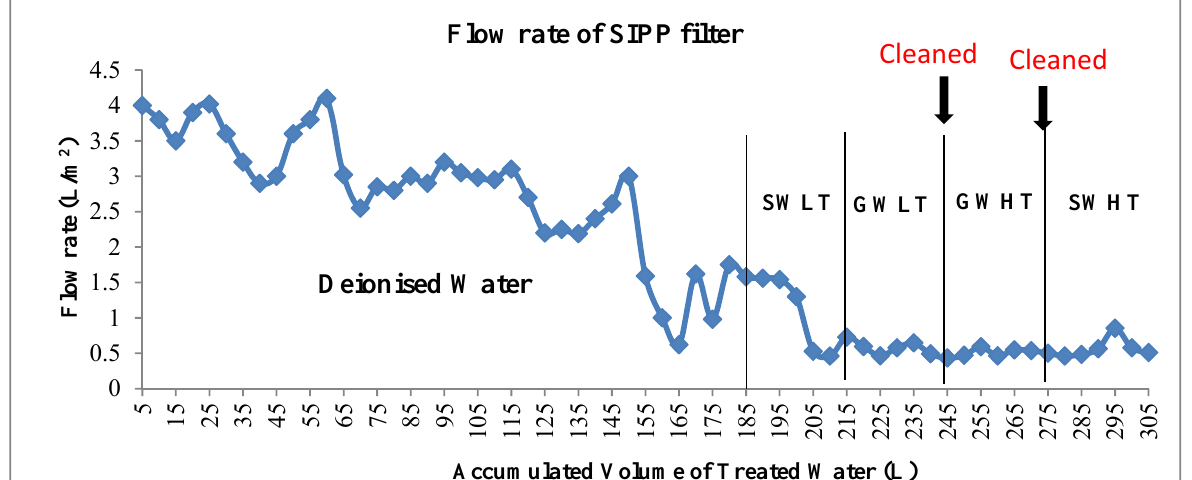
Figure 2. Flow rate (average of two filters) of SIPP filter for different water source